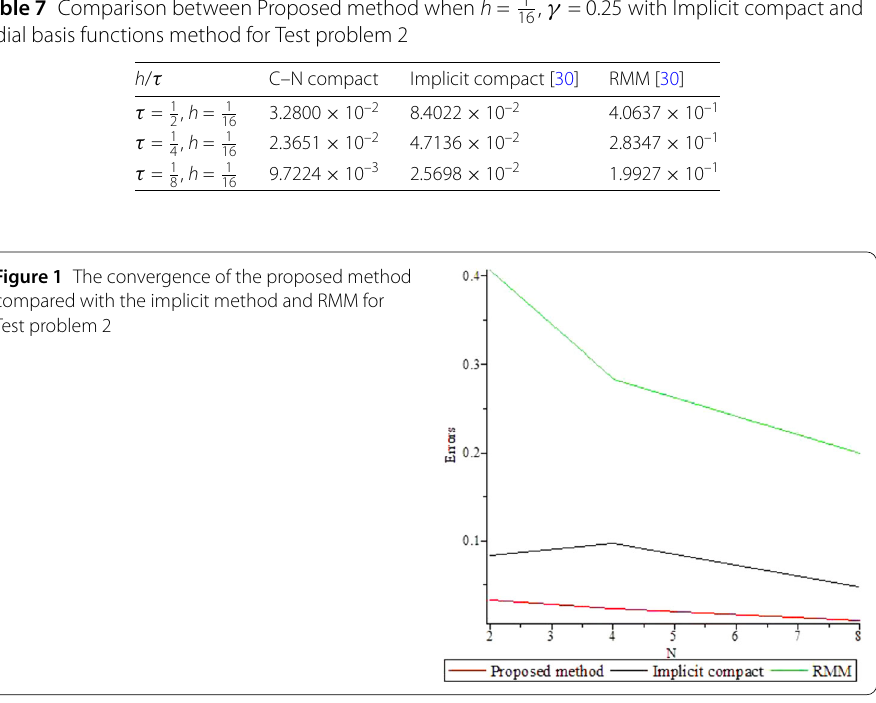
, γ = 0.25 with Implicit compact and 16